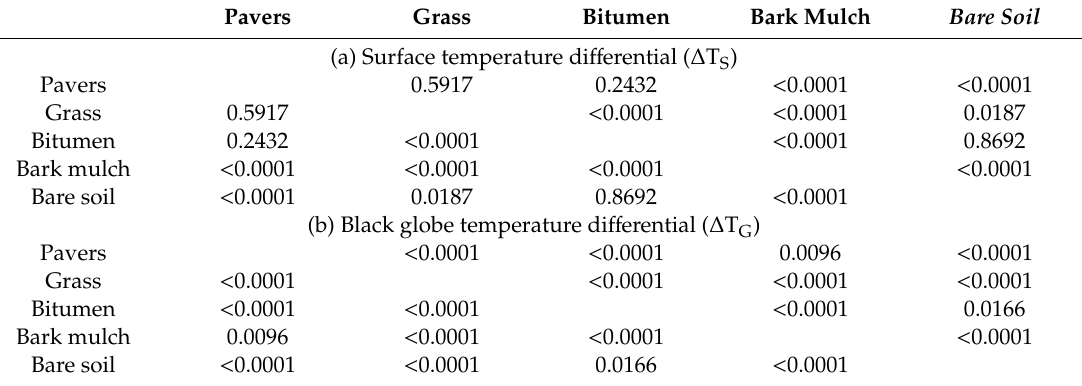
Table 3. Tukey’s HSD pairwise comparison of the surface temperature di ff erential ( ∆ T S ) and black globe temperature di ff erential ( ∆ T G ) observed among the five surface types: concrete pavers, grass, bitumen, bark mulch and bare soil. Pavers Grass Bitumen Bark Mulch Bare Soil 0.5917